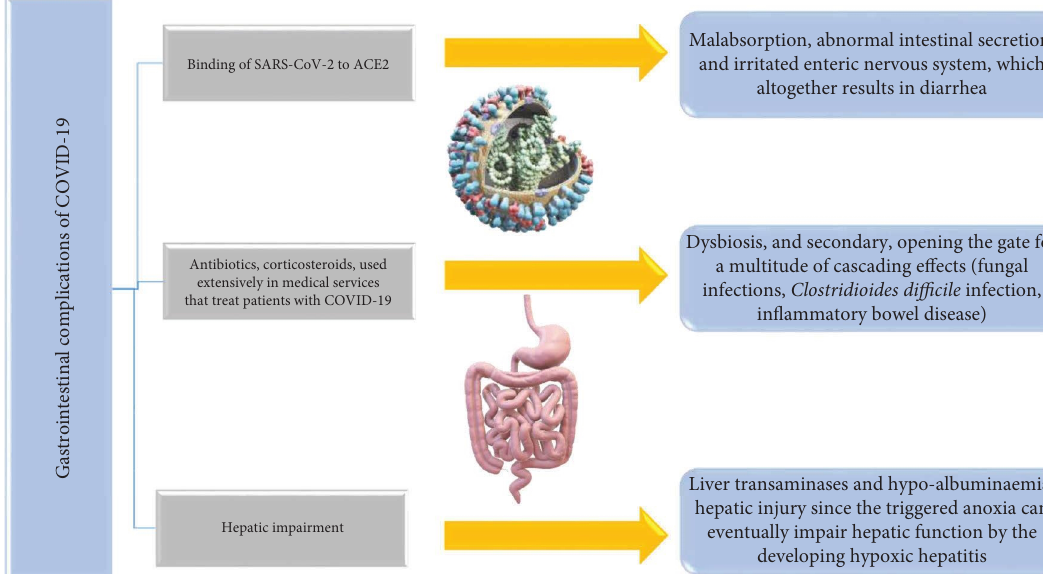
Figure 5: Gastrointestinal complications related to the viral